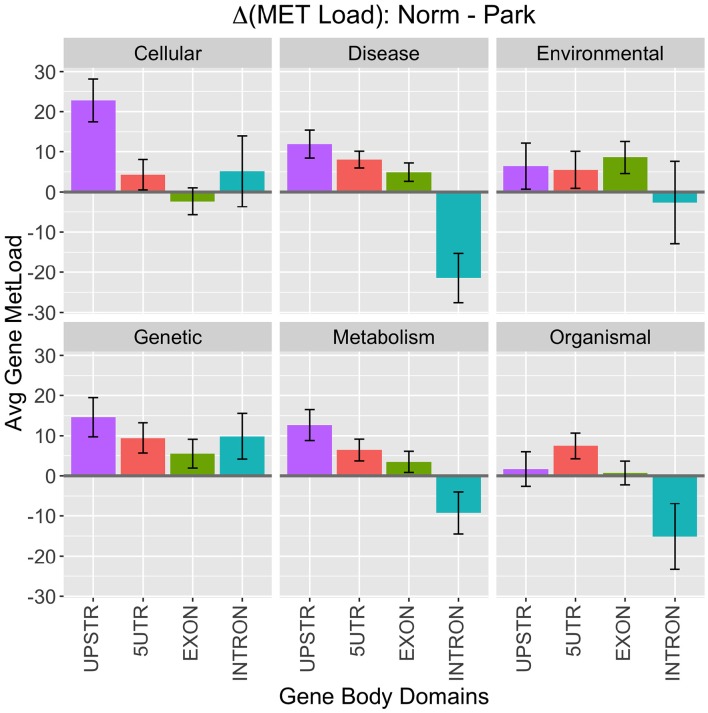
KEGG Class Processes. High-level breakdown of methylation load (ΔML) among functional KEGG class designations and gene body domains. Positive numbers indicate higher methylation in healthy males and negative numbers indicate higher methylation in Parkinson's Disease patients. Values plotted are means ± SE across the number of genes in each category.